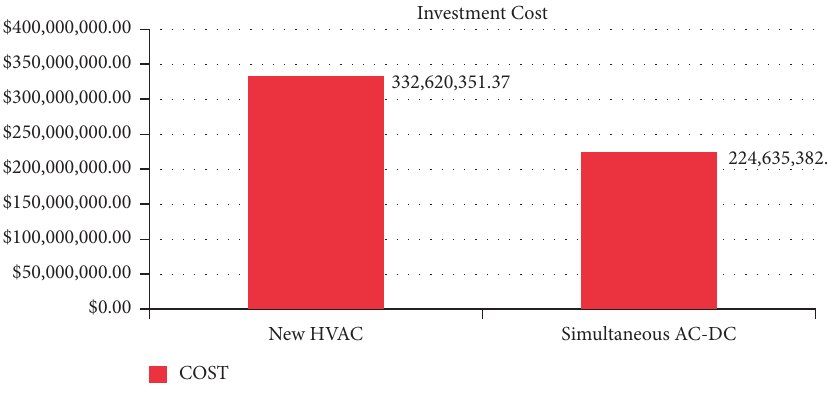
Figure 2: Investment cost comparisons. Table 6: Data used for life cycle cost